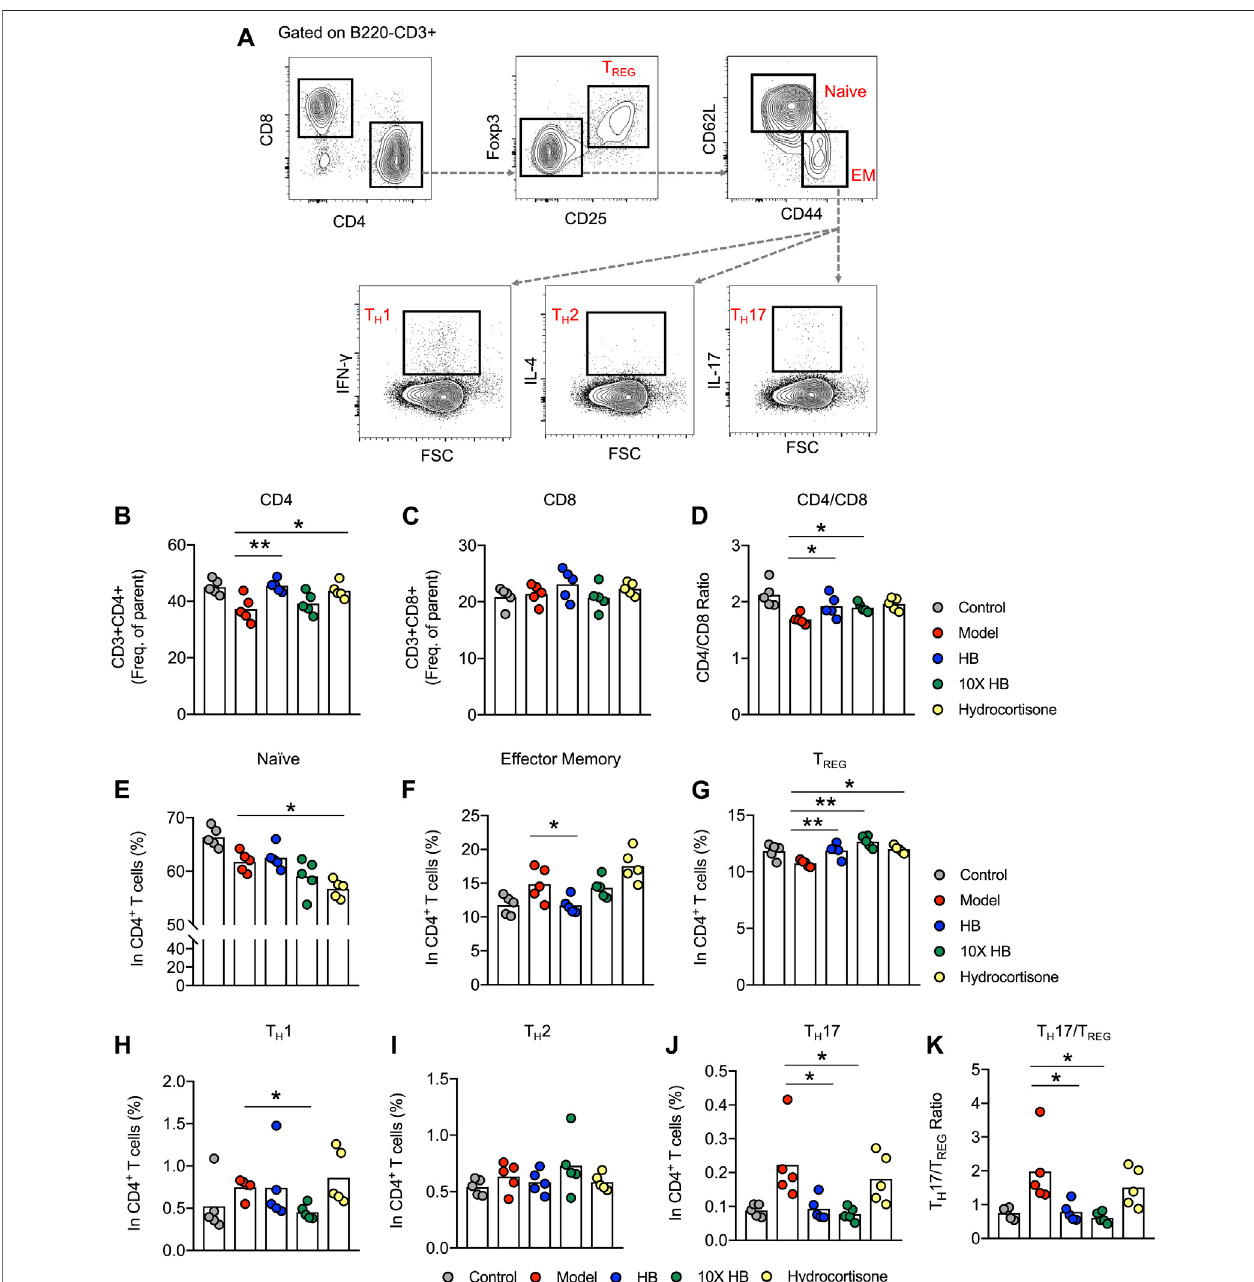
FIGURE 3 | HB relieves skin in fl ammation by downregulation of the T H 17/T REG ratio. Mice were sensitized with 1% DNCB on dorsal skin at days 0and 3, and then challenged with 0.4% DNCB on the dorsum of both ears at 3 day intervals from days 5 to 20. HB, 10X HB (a 10-fold concentration of HB), hydrocortisone, or PBS, was topicallyapplieddailytothedorsalskinoftheDNCB-inducedmice.SplenocytesofADmodelmicetreatedwithPBS,HB,10XHB,andhydrocortisonewereisolatedand stained using immuno fl uorescence antibodies. (A) Gating strategy for different T cell subsets. (B,C) Statistical analysis of the frequencies of B220 − CD3 + CD4 + T cells (B) and B220 − CD3 + CD8 + T cells (C) in different groups. (D) CD4/CD8 ratio. (E – J) Statistical analysis showing the differences in the frequencies of naïve (E) and effector memory (F) CD4 T cells and T REG (G) , T H 1 (H) , T H 2 (I) , and T H 17 (J) cells. (K) The T H 17/T REG ratio was calculated to show the differences in different groups. Each dot represents one mouse from one of three independent experiments, and bars indicate mean values. Statistical signi fi cance was determined by one-way ANOVA, * p < 0.05, ** p < 0.01.